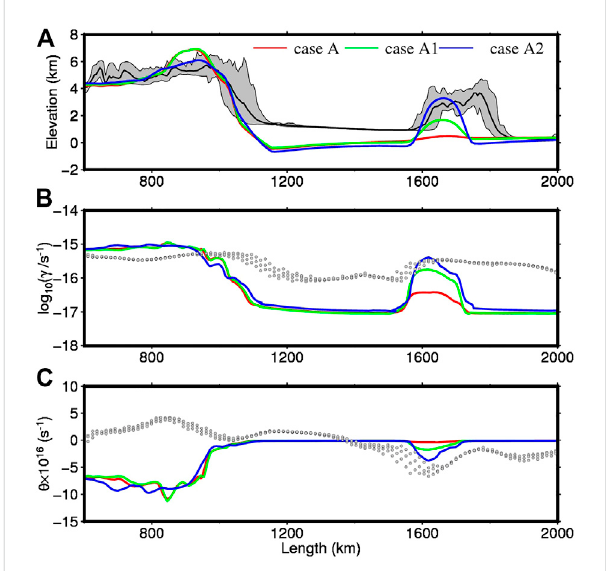
FIGURE 5 Comparisons of the results of numerical models (group A) with the observed surface topography (A) , the maximum shear strain rate (B) , and the dilatation strain rate (C) across the northern margin of the TibetanPlateau(AA ’ pro fi leinFigure1B).Grayareasin (A) indicate the observed topographic change. Gray dots in (B – C) indicate the observed strain rates (Kreemer et al., 2014; Wang and Shen,